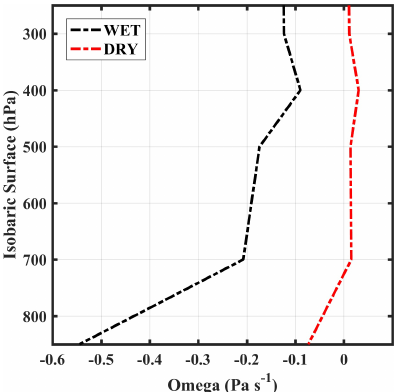
Figure 10. The mean profile of omega for wet and dry spells.